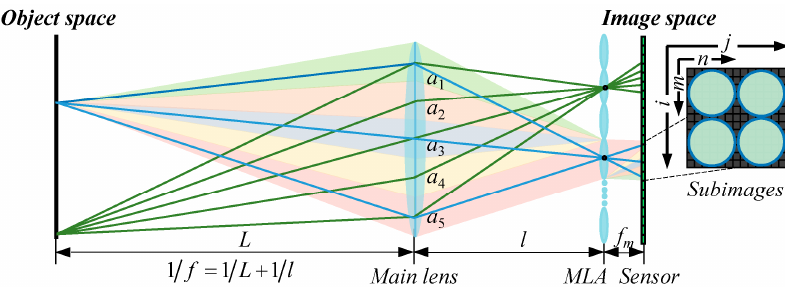
Figure 1. Optical configuration and ray tracing of an unfocused plenoptic imaging system.